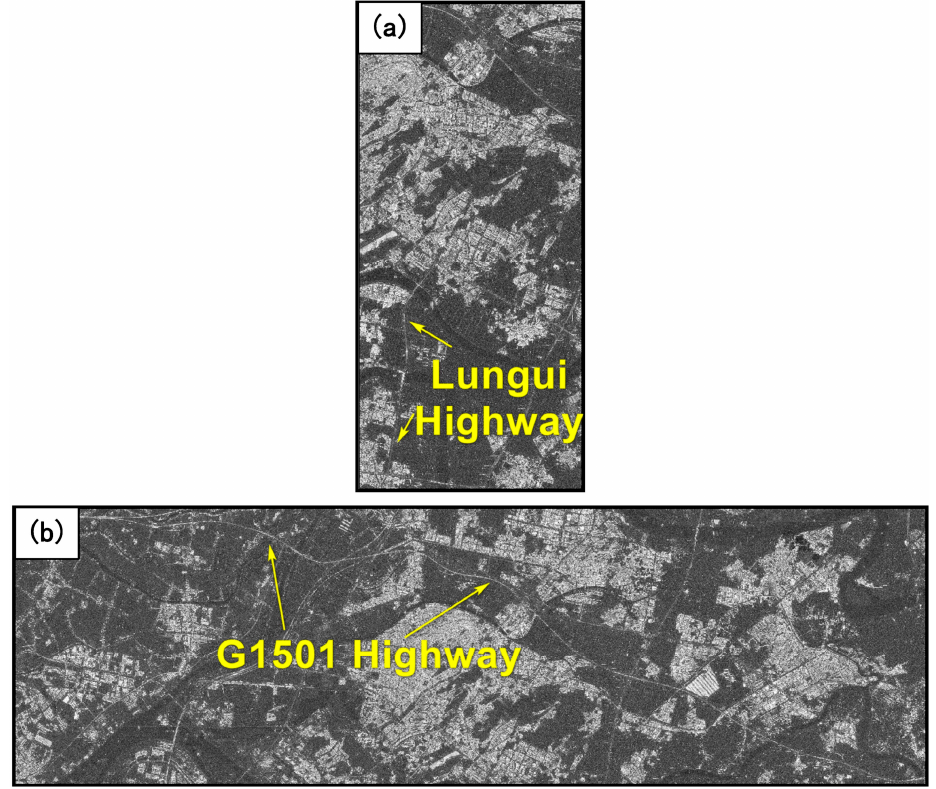
Figure 4. Average coherence maps. ( a ) Lungui Highway; ( b ) G1501 Highway.